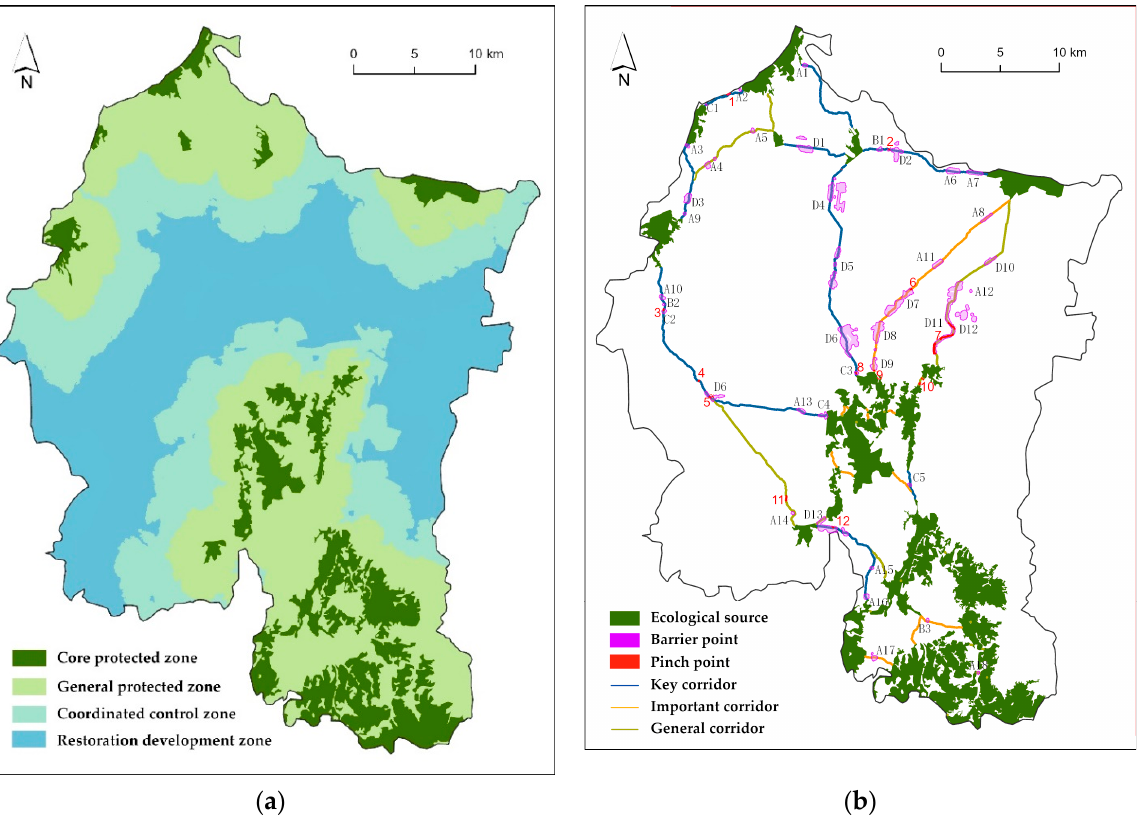
Figure 11. Ecological-security pattern of Liyang City. ( a ) Zoning of ecological security; ( b ) spatial distribution of ESP components.